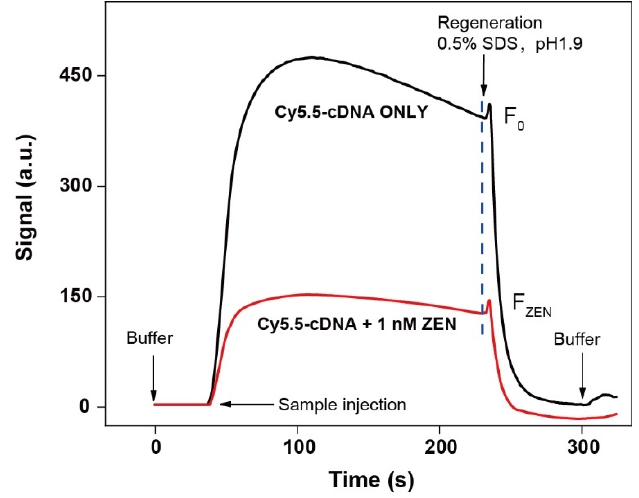
Figure 3. Representative in situ signal responses of the EWOF aptasensor for the detection of 1 nM ZEN (red curve). The black curve is the reference signal in the absence of ZEN (blank sample). The fluorescence intensities of the samples with or without ZEN (F ZEN or F 0 ) immediately before the injection of the regeneration buffer (0.5% SDS, pH 1.9) was used to calculate the signal decrease percentage (S% = (F 0 − F ZEN )/F 0 ).